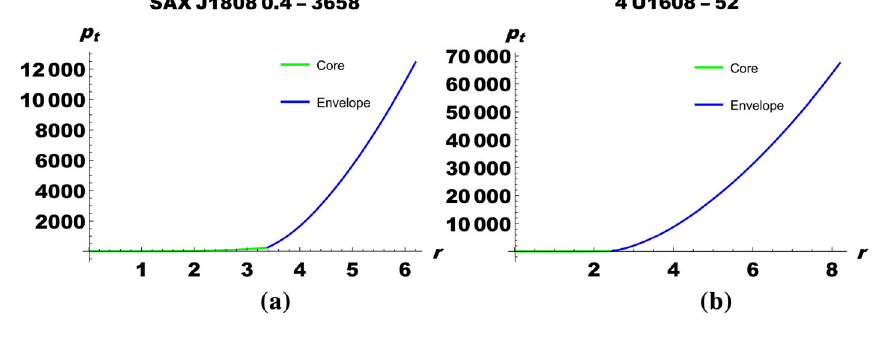
Fig. 4 variation of pressure and density ratio with radial coordinate